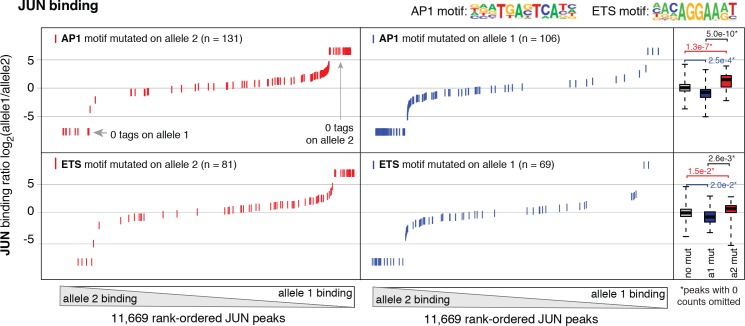
Allele-specific JUN binding at loci with mutated motifs.JUN binding was measured by ChIP-seq in a HAEC donor with whole-genome sequencing information. Allele-specific JUN binding was calculated at heterozygous loci (y-axis is JUN binding ratio between alleles). Allele-specific motif mutations were calculated as instances where an allele mutated the AP1 (top panels) or ETS (bottom panels) canonical binding motif. Box plots to the right show the distribution of JUN peaks in one of three categories: all heterozygous peaks without mutations in grey; peaks where motifs were mutated on allele one in blue; and peaks where motifs were mutated on allele 2 in red. p-values result from two-sided t-test and exclude peaks where 0 counts are observed on one of the two alleles. These sites were excluded because the allele-specific binding ratio (y-axis) should be ± infinity in instances of 0 counts on one allele. To avoid complications this brings to the t-test, we excluded these sites. Thus, our p-values are very conservative because the sites with 0 counts on one allele are highly informative for the effect of motif mutations on binding (i.e. they are the most extreme examples).